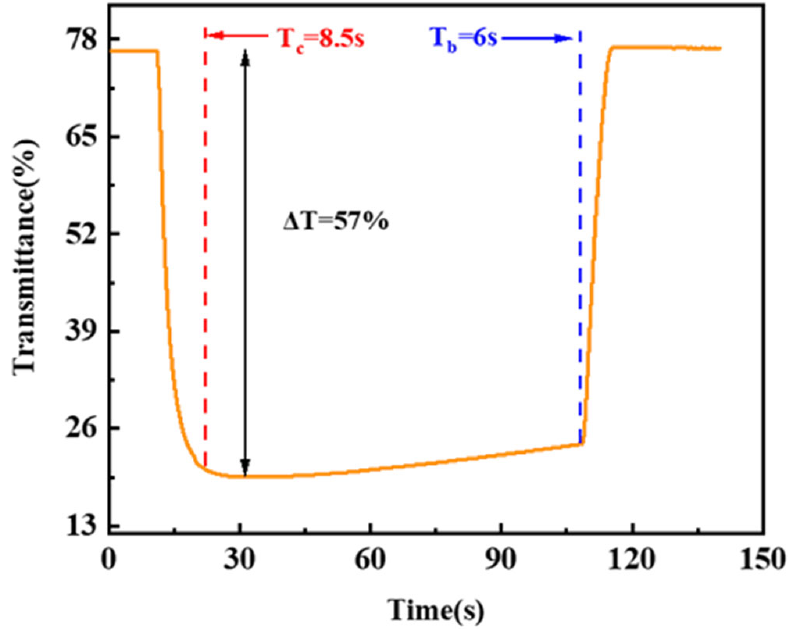
Figure 6. The transmittance–time diagram at 700 nm for the 0.175 mol/L ammonium metatungstate × 0.30 mol/L iron (II) chloride group at a current density of 6 A/m 2 . Table 2. Comparison of electrochromic (EC) materials, film preparation methods, and transmittance modulation ( Δ T) between the literature and this work.